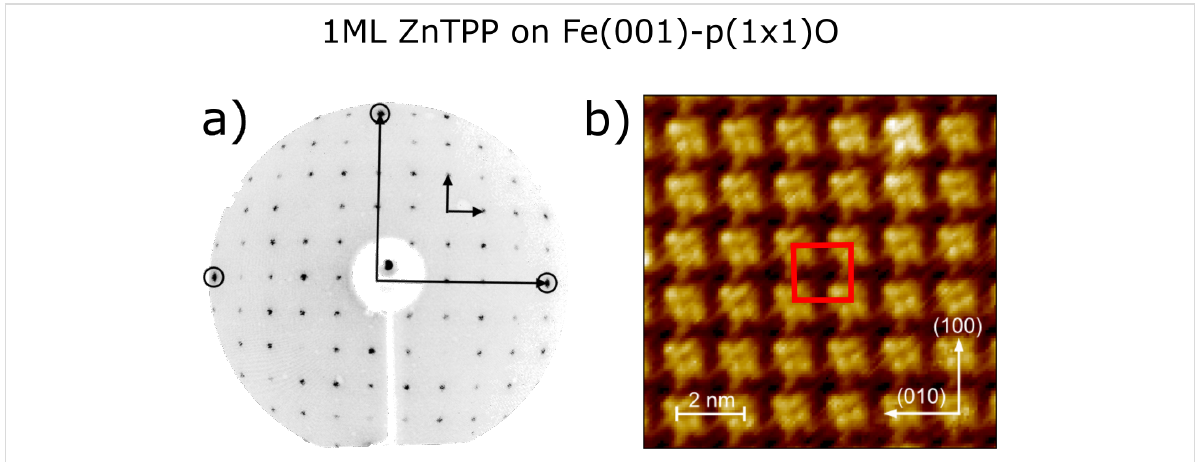
Figure 1: (a) LEED pattern of the system 1 ML ZnTPP /Fe(001)– p (1 × 1)O acquired with a beam energy equal to 55 eV. In the circles, the spots from the bare Fe(001)– p (1 × 1)O surface are highlighted. The arrows indicate the unit vectors in the reciprocal space of the substrate (long arrows) and after the deposition of the organic film (short arrows). (b) STM image of the ZnTPP overlayer. Tunneling parameters V = 1.5 V, I = 500 pA, image size 11 × 11 nm 2 . The red square indicates the (5 × 5) unit cell. In the lower right corner, the crystallographic directions are indicated.